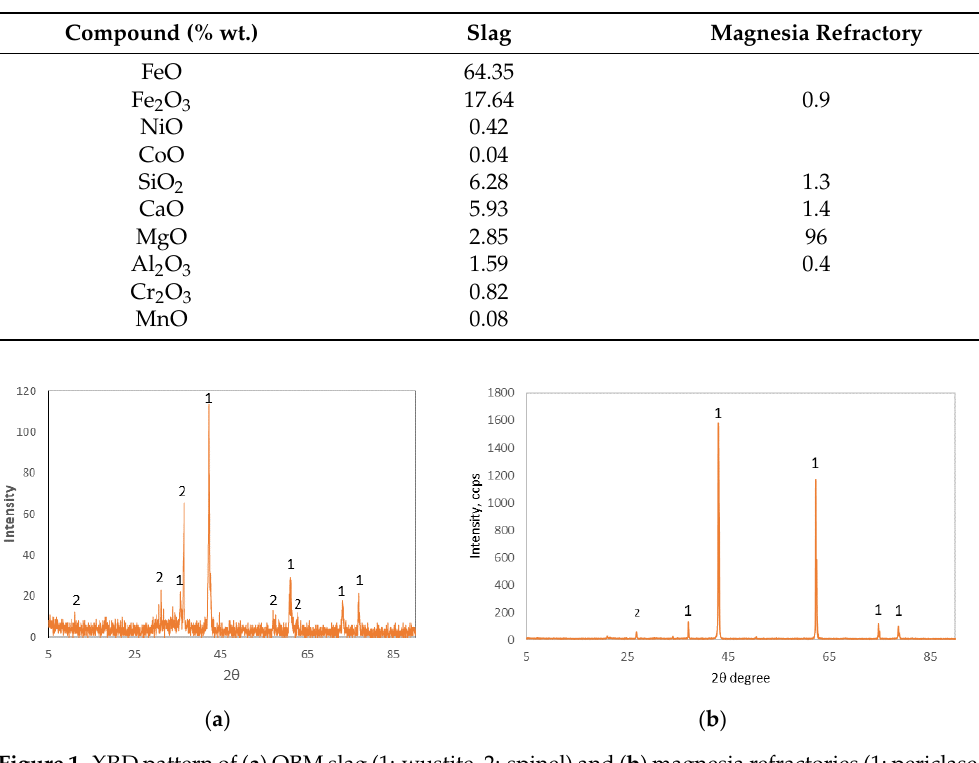
Figure 1. XRD pattern of ( a ) OBM slag (1: wustite, 2: spinel) and ( b ) magnesia refractories (1: periclase, 2: quartz).